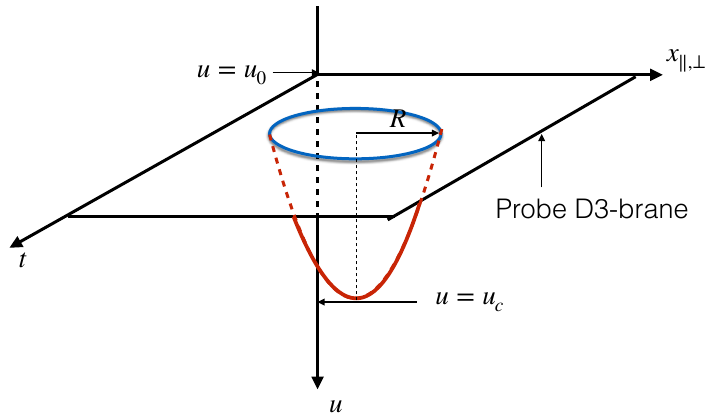
Figure 8 . The circular Wilson loop (blue line) on a probe D3-brane at u = u 0 with a fundamental string (red line) stretched in the